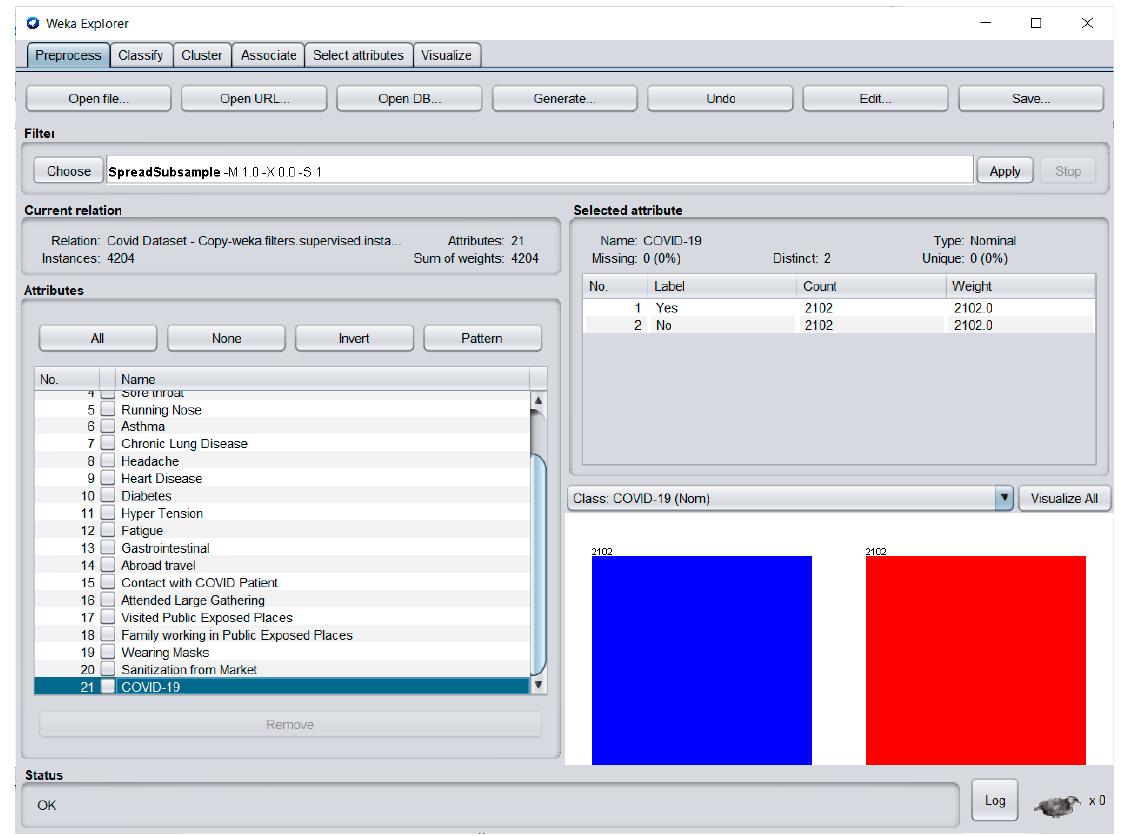
Figure 5. The Preprocess tab of WEKA Explorer showing the result of balancing the dataset through Spread Subsample or undersampling the majority class to make it equal to the minority class.